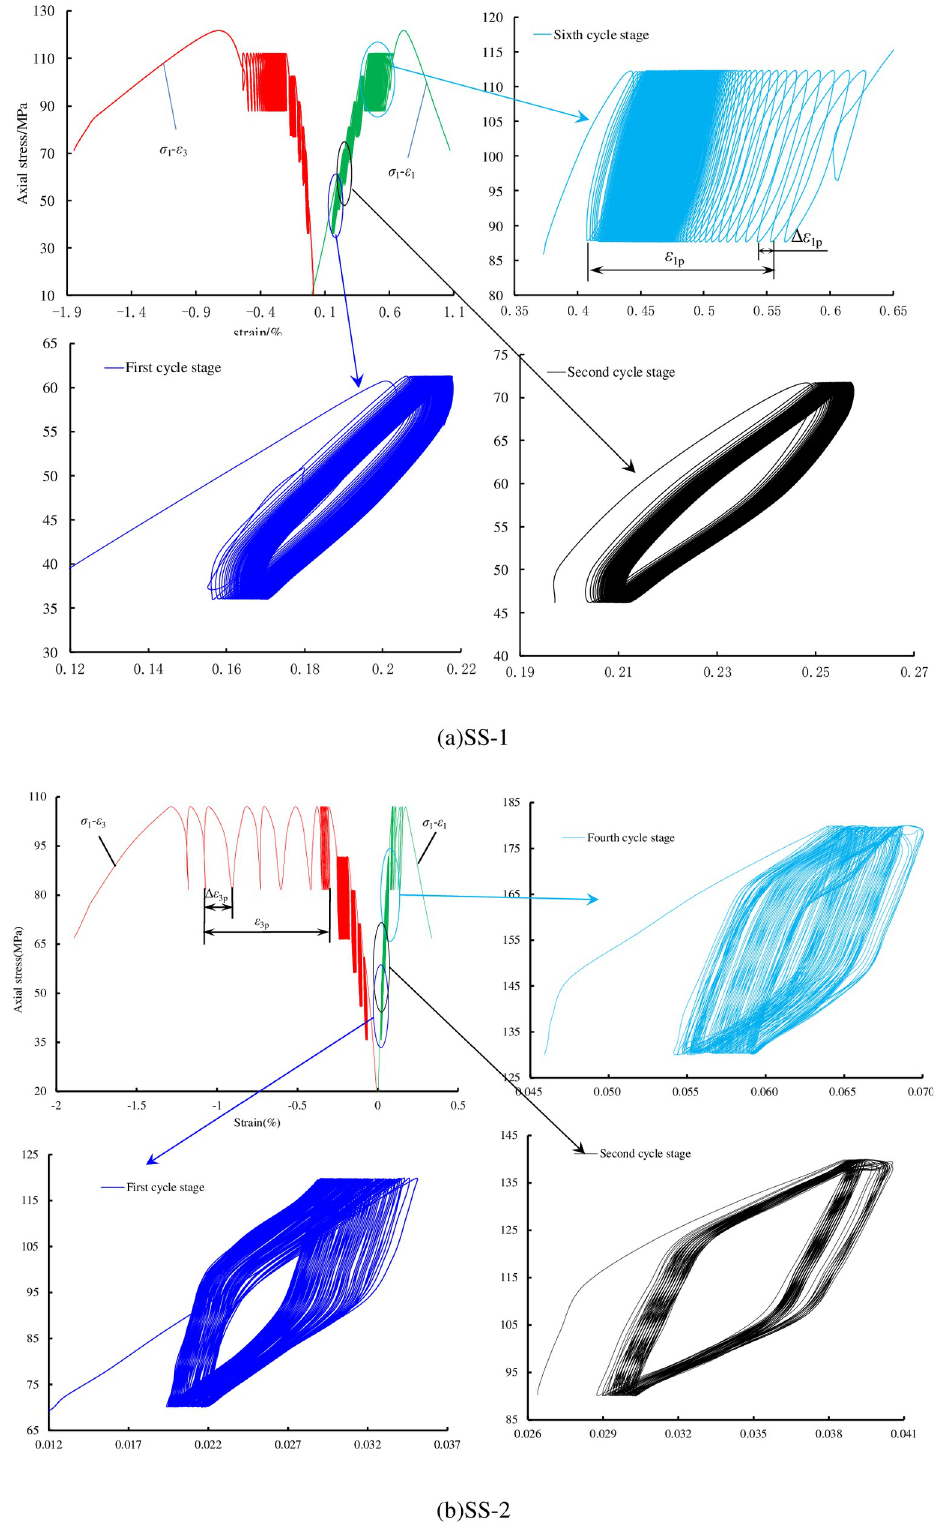
Fig 6. Full stress-strain curves and local enlarged diagrams of sandstone under multilevel cyclic loading.